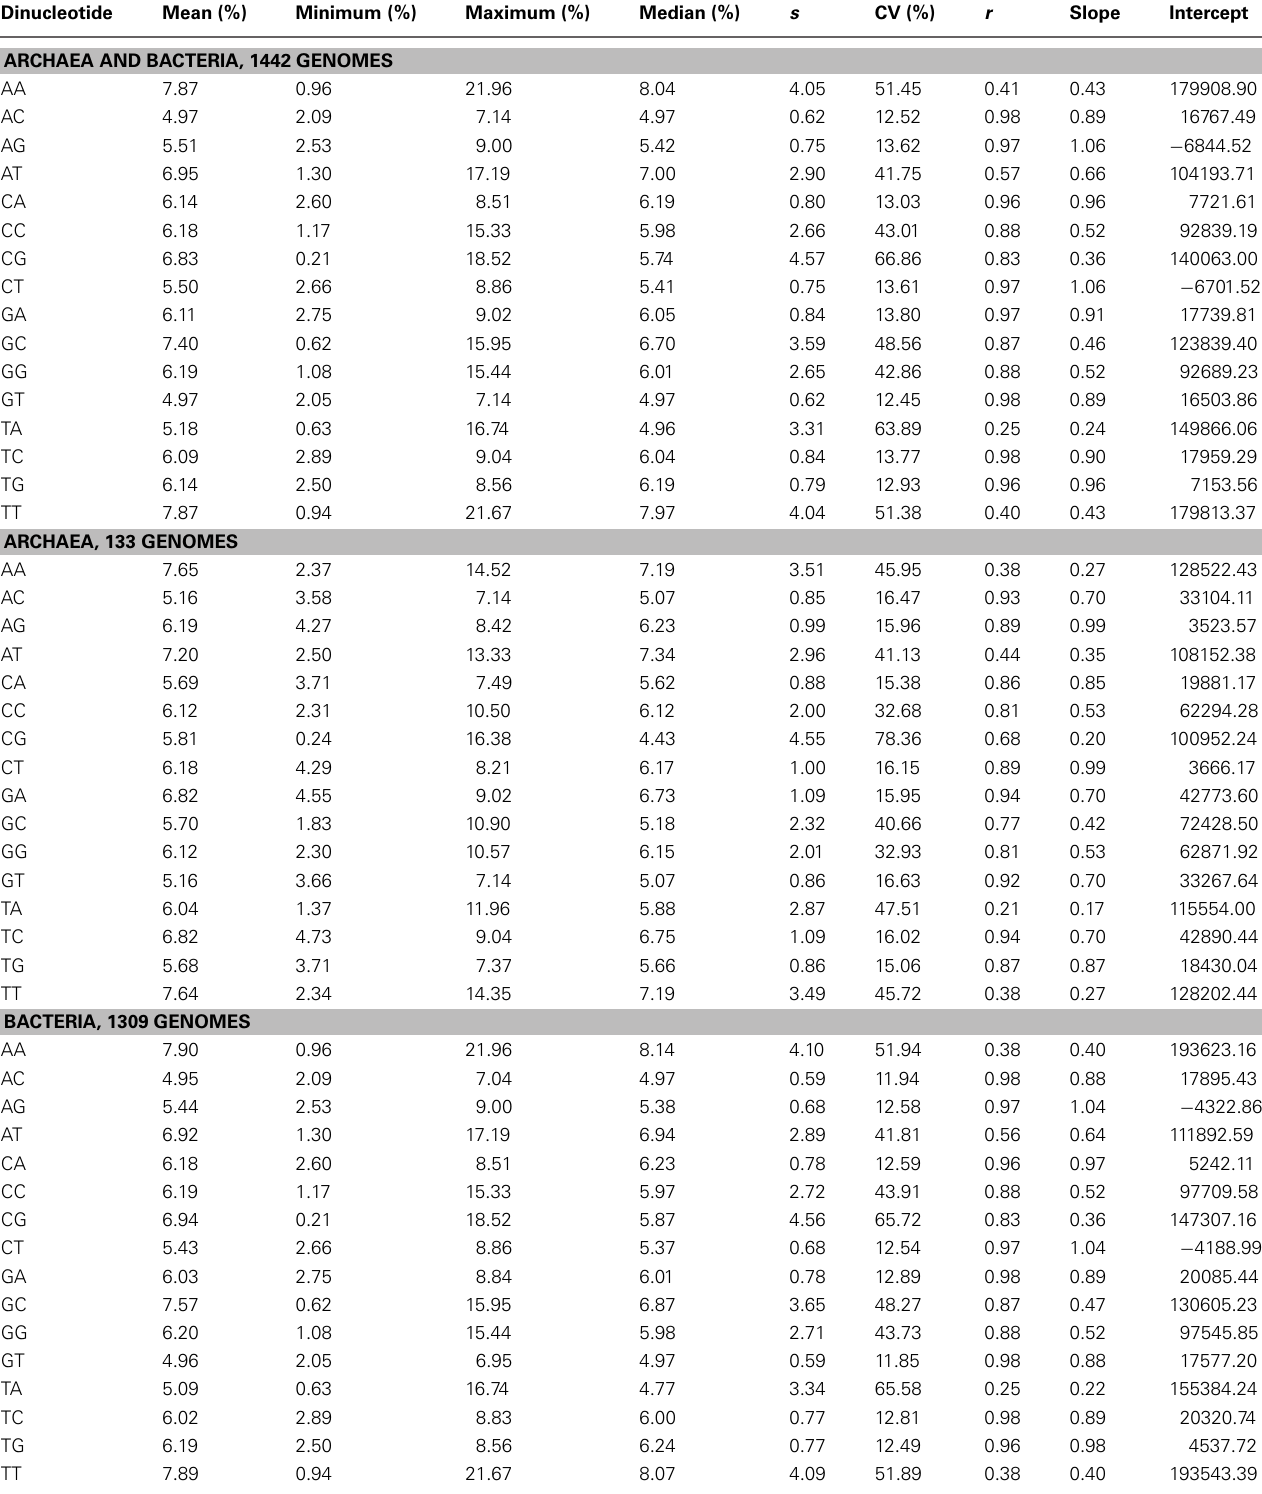
Table 1 | Statistical analysis of dinucleotide frequencies and counts across genomes. Dinucleotide Slope ARCHAEA AND BACTERIA, 1442